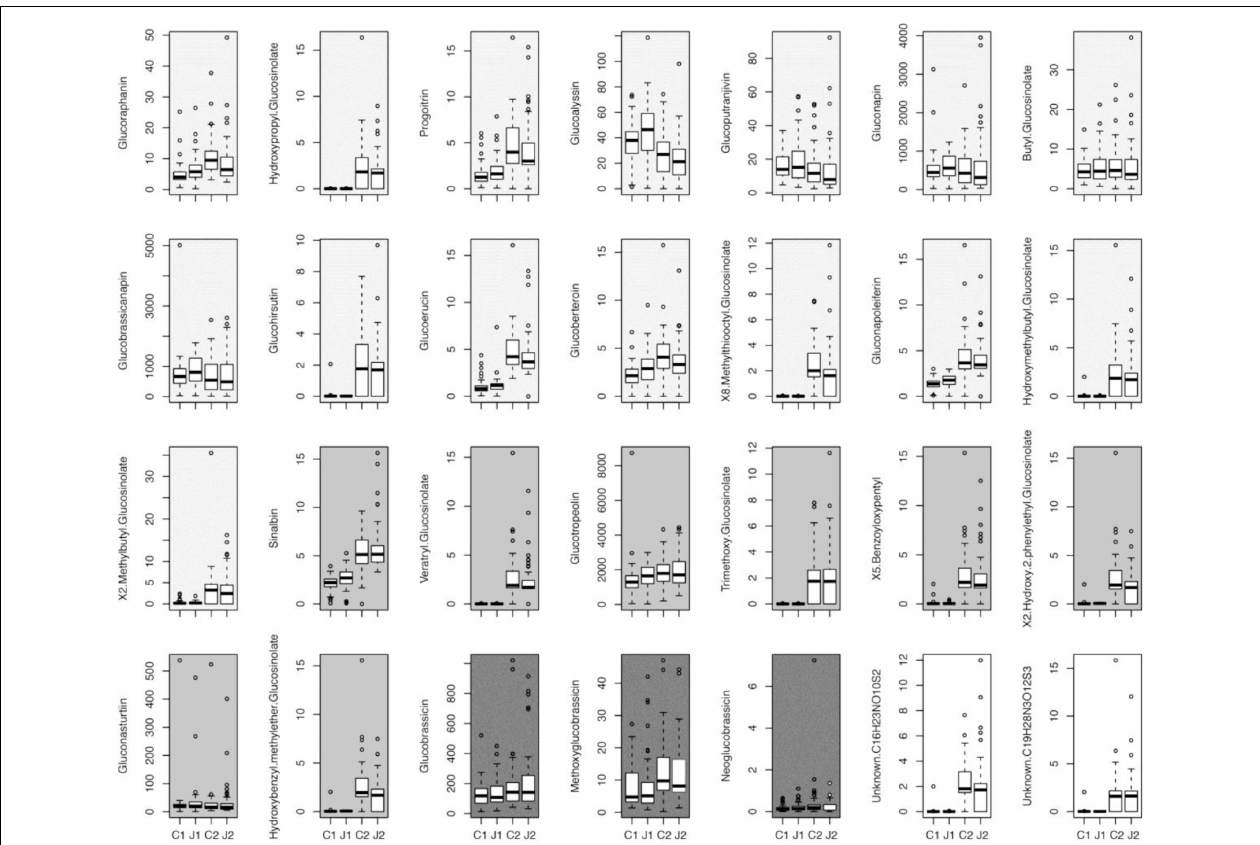
FIGURE 2 | Individual glucosinolate induction. Data show the effect of JA induction in the roots, at two different time points (J1 and J2) and no JA induction (C1 and C2), on individual glucosinolates (ng mg - 1 FW) levels in the leaves of Cardamine hirsuta plants. C2 and J2 also represent 7 days of Spodoptera littoralis herbivore attack. Different shadings of gray indicate different classes of GSLs: from light to dark: unknown (white), aliphatic, aromatic, and indole.